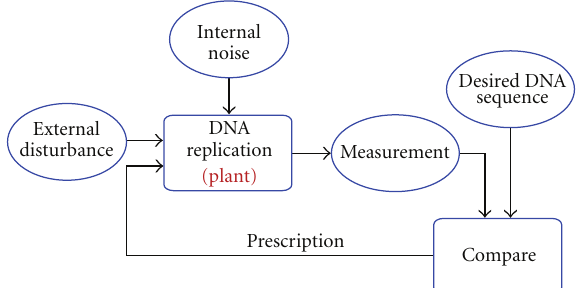
Figure 3: System diagram of restoring an abnormal DNA segment back to a normal sequence by applying mutagens during the process of DNA